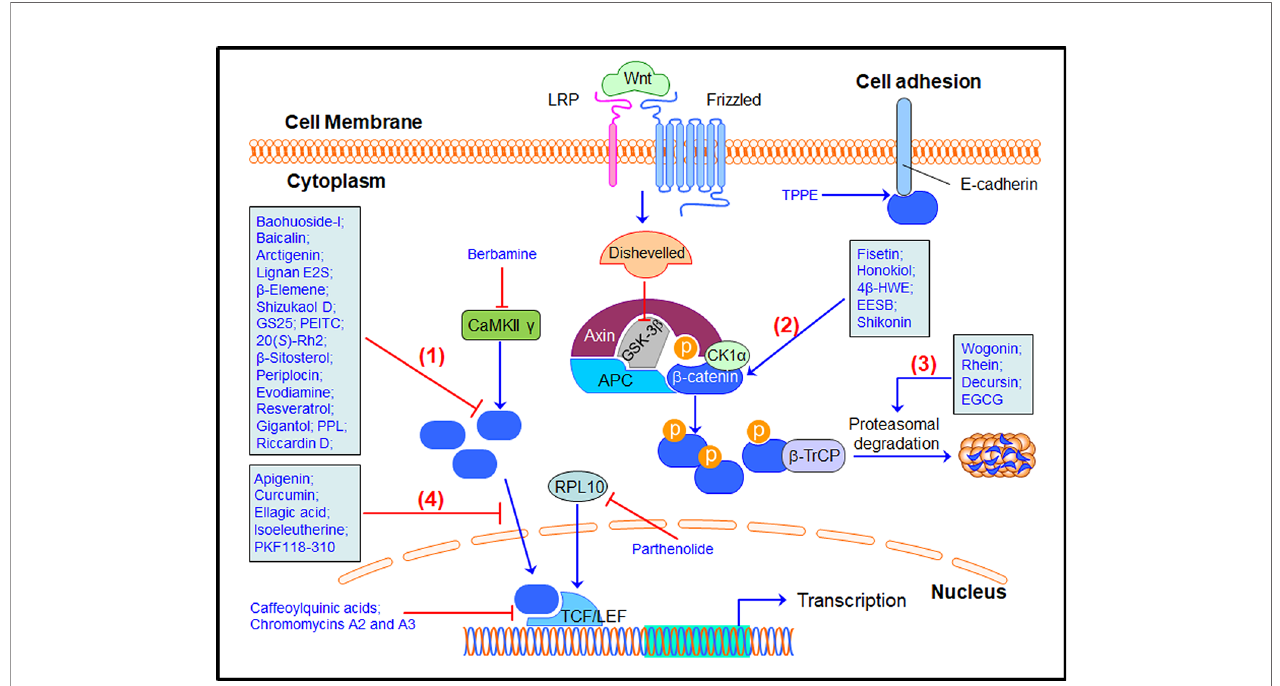
FIGURE 2 | Natural products targeting the b -catenin signaling pathway for cancer therapy. Many natural products have been discovered to inhibit the b -catenin signaling pathway through (1) down-regulating b -catenin expression, (2) modulating b -catenin phosphorylation, (3) promoting b -catenin protein degradation, (4) inhibiting b -catenin nuclear translocation, and other mechanisms of action. 20( S )-Rh2, 20( S )-ginsenoside Rh2; 4 b -HWE, 4 b -Hydroxywithanolide E; AEUT, alkaloid- enriched extract of Uncaria tomentosa ; APC, adenomatous polyposis coli; b -TrCP, b -Transducin repeat-containing protein; CK1 a , casein kinase 1 a ; EGCG, epigallocatechin-3-gallate; EESB, ethanol extract of Scutellaria barbata D. Don; GS25, 20( S )-25-OCH 3 -PPD; GSK3 b , glycogen synthase kinase 3 b ; LRP, low-density lipoprotein receptor-related protein; PEITC, phenethyl isothiocyanate; PPL, polysaccharides from Phellinus linteus ; TCF/LEF, T cell factor/lymphocyte enhancer factor; TPPE, Teucrium polium plant